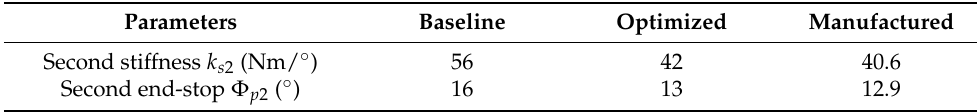
Table 1. Optimized clutch